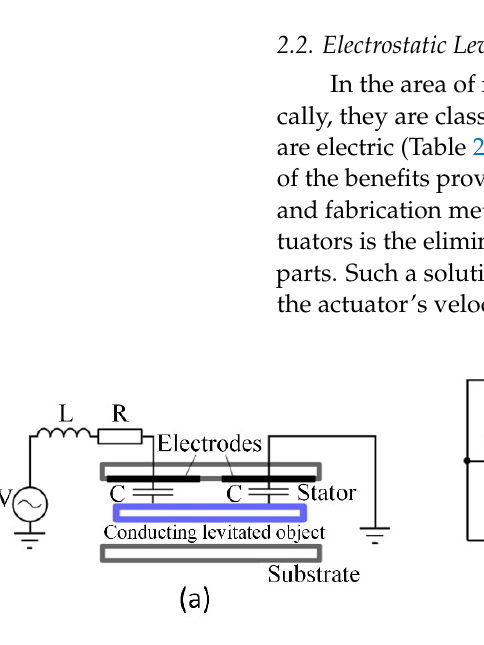
Figure 3. Electric levitation microactuators based on the passive levitation: ( a ) single-stator design, V—electric potential, L—inductance, R—resistance, C—electric charge; ( b ) dual-stator design; ( c ) levitation of a charged particle in a hyperbolic oscillating electric field E (U is the applied electric potential). Adapted from [46].